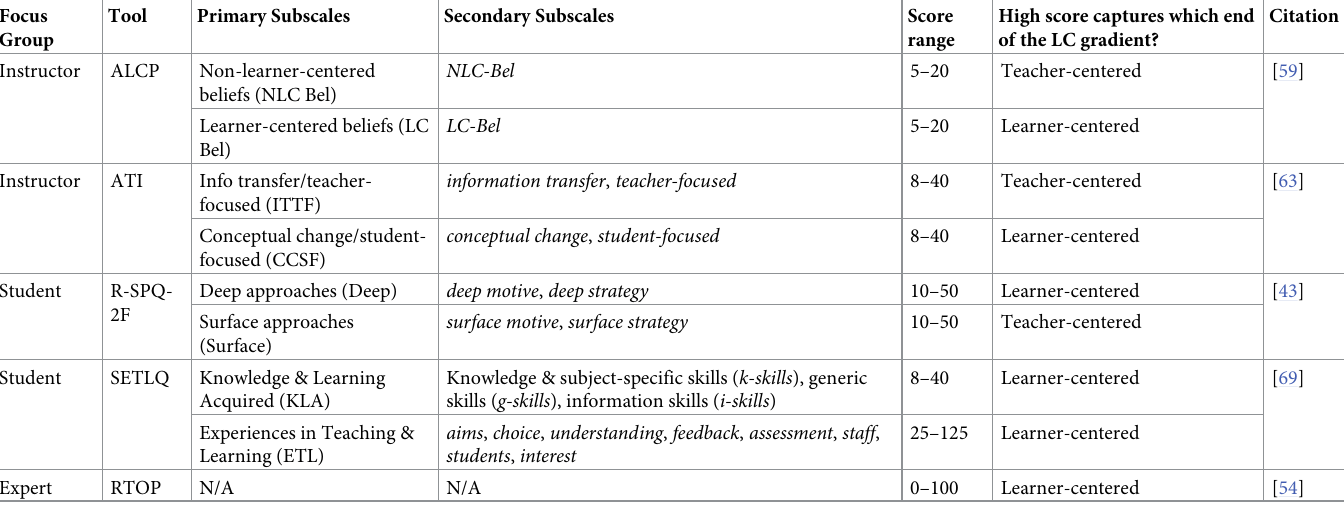
Table 1. Five instruments for comparing perceptions of learner-centeredness. Within each student and instructor instrument exists primary and secondary subscales that we used in our study; we indicate the possible score ranges for each subscale and at which end of the learner-centered (LC) gradient a high score on that subscale would